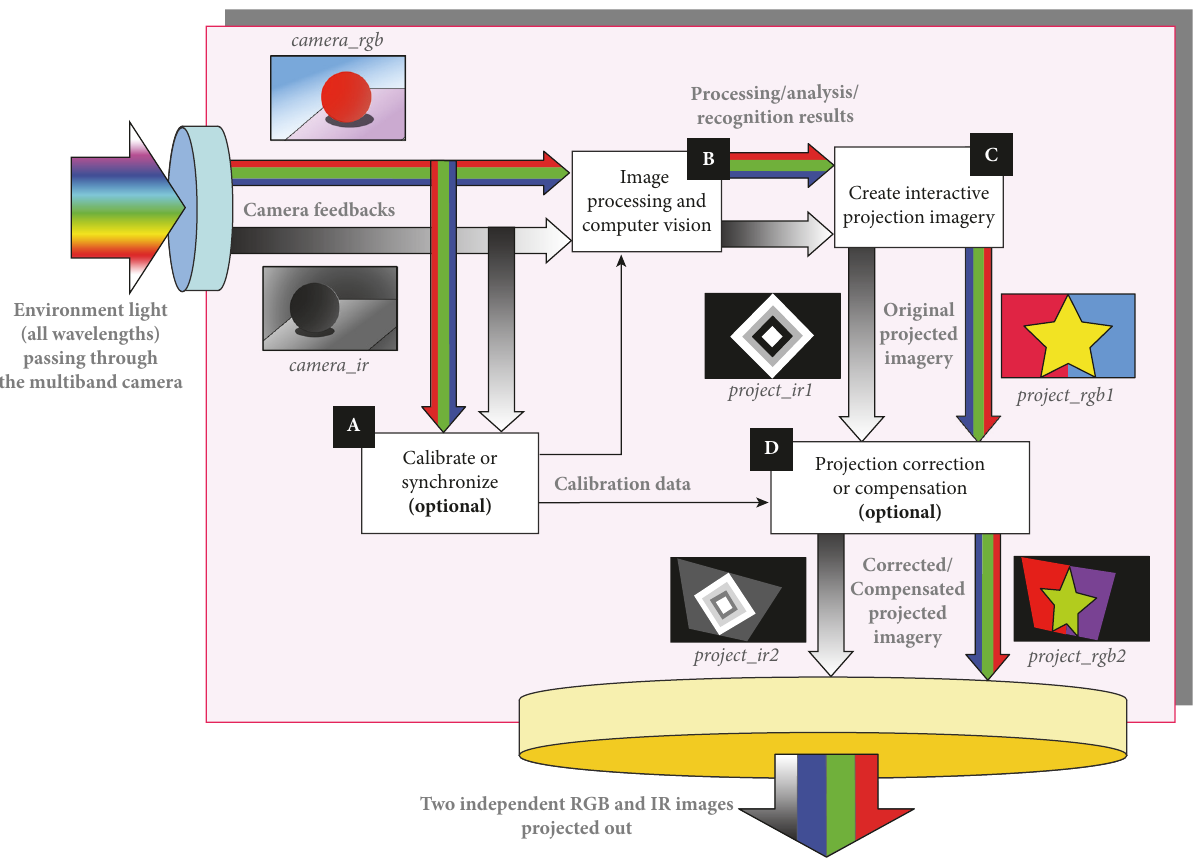
Figure 6: Diagram explaining main computational modules for the proposed pro-cam design. Modules A and D are optional and can be omitted if not required by a system. This diagram corresponds to the four-channel projected image (explained in Section 4.1.1) but can be used for the five-channel projected image as well with slight